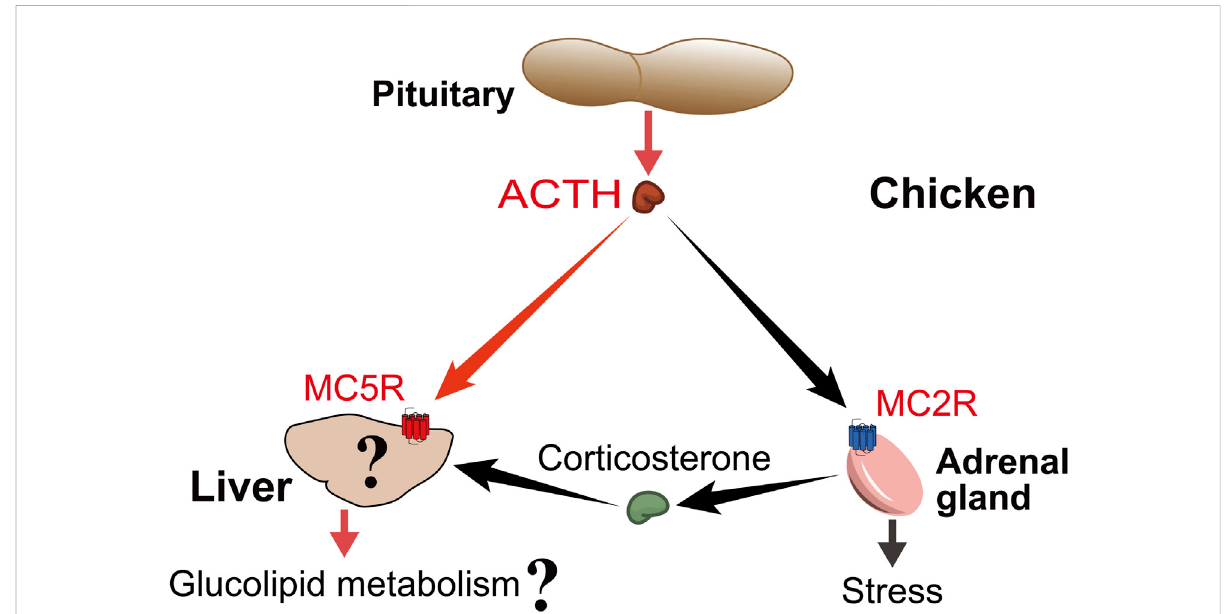
FIGURE 9 Proposed model for ACTH actions on chicken liver. Pituitary-derived ACTH hormone can act not only on MC2R, which is highly expressed in adrenal tissue, to participate in the stress, but also on MC5R, which is highly expressed in liver tissue, to participate in the regulation of glucolipid metabolism.Atthesametime,theliverisalsothemaintargetorganofACTH-inducedcorticosterone,soitisworthwhiletoinvestigatethedifference between the direct effect of ACTH and the effect of